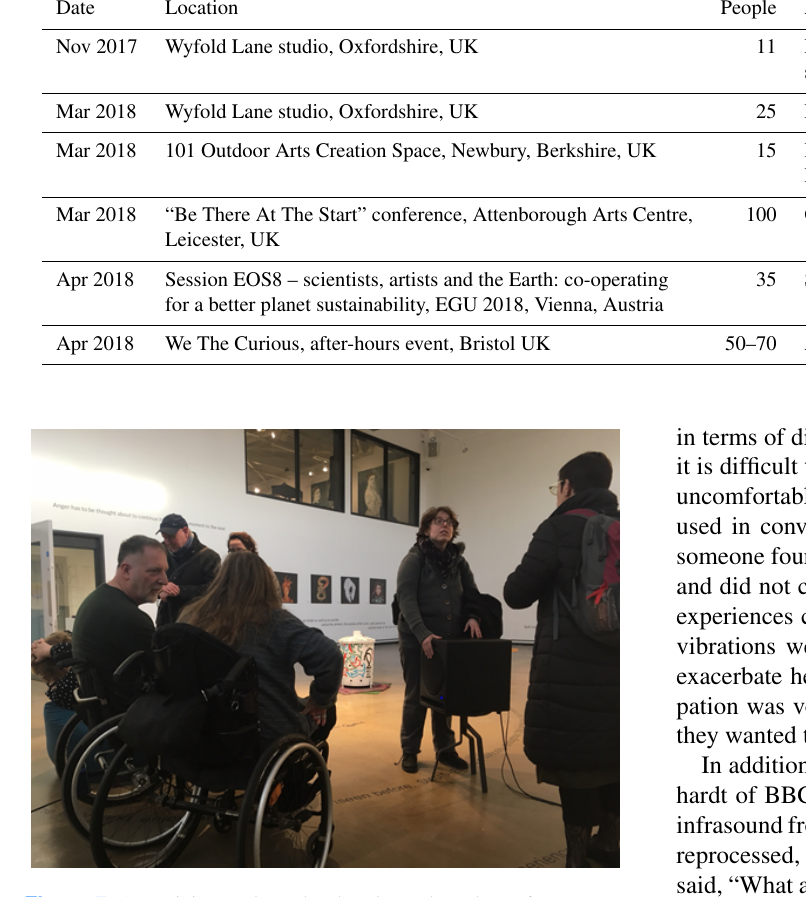
Figure 7. A participant places her hands on the subwoofer to expe- rience the processed infrasound at the “Be There At The Start” fes- tival, Attenborough Centre, Leicester. Photo credit: Glenn Bryant.